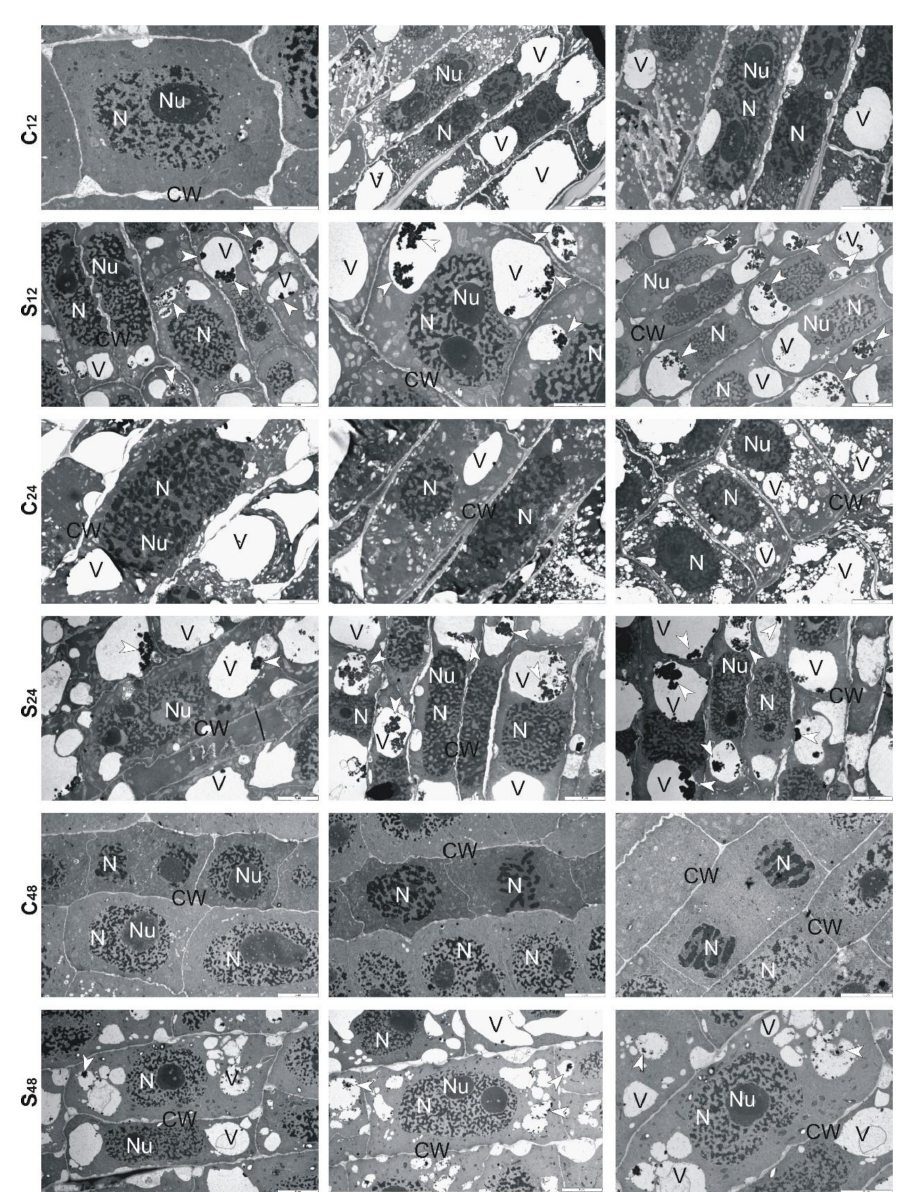
Figure 8. Representative results of the ultrathin sections taken from the roots of sensitive triticale cv. “Subito” at 12, 24 and 48 h after treatment with Al 3+ (0.59 mM) (S) and in untreated plants